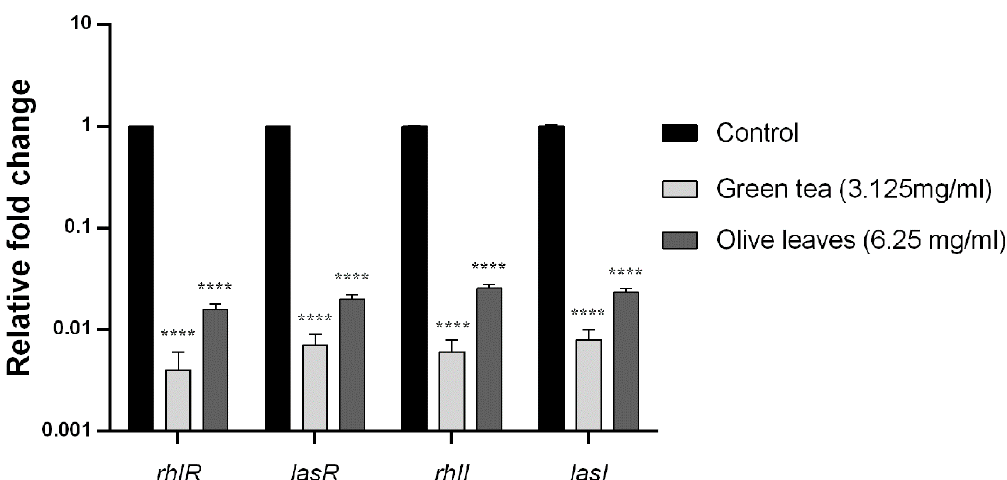
Figure 4. Effect of Camellia sinensis and Olea europaea extracts on the transcription of quorum sensing (QS)-regulated genes of P. aeruginosa C21. Bar chart of the qRT-PCR analysis representing the relative transcription levels of lasI , lasR , rhlI , and rhlR genes treated with sub-MIC levels of Camellia sinensis (3.125 mg/mL) and Olea europaea (6.25 mg/mL), normalized with the reference gene 5s RNA and compared to the untreated control. The error bars indicate the standard deviations of three replicates. **** = p < 0.0001: significance was compared to the respective control.